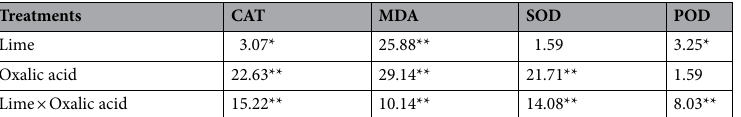
Table 3. Variance analysis of the effects of oxalic acid, calcium and cadmium on antioxidant enzyme activity and the contents of malondialdehyde in the roots of Panax notoginseng (F value). In the two-way analysis of variance, * indicates P < 0.05, and ** indicates P < 0.01.